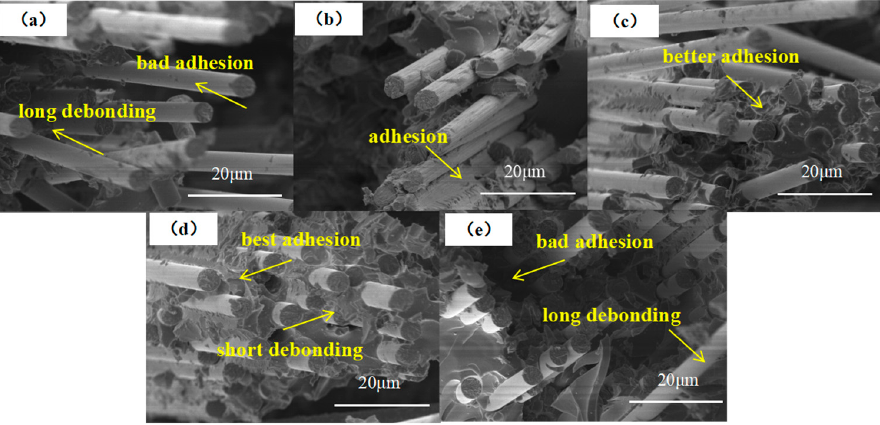
Figure 8. Fracture morphology of CF composites ( a ) CF; ( b ) MOF/CF-5; ( c ) MOF/CF-7; ( d ) MOF/CF-9; ( e ) MOF/CF-11 .